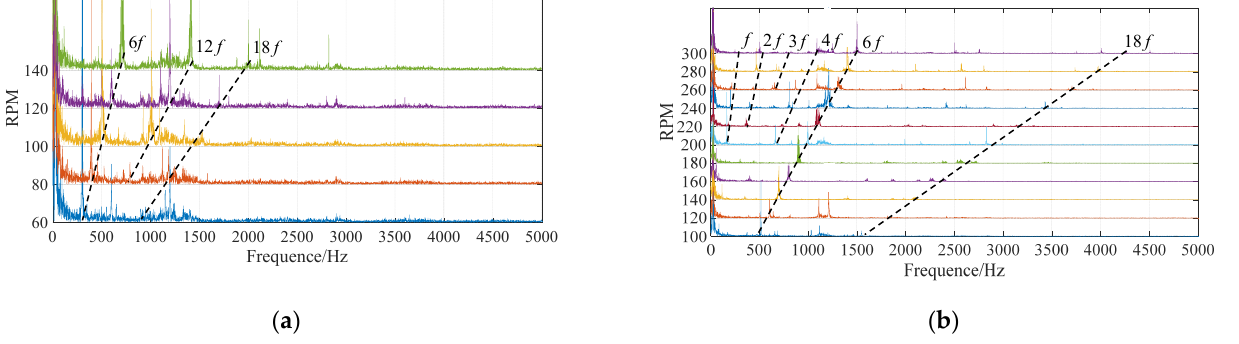
Figure 11. Testing results. The effects of current harmonics on the waterfall: ( a ) half-step subdivision mode in loaded operation; ( b ) sensorless FOC mode in loaded operation.